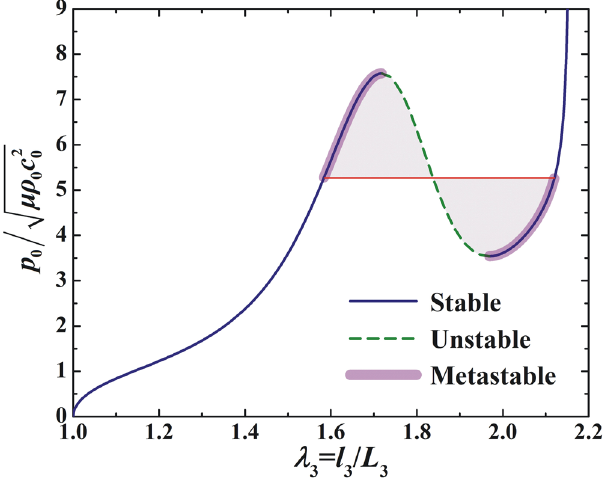
Figure 4. The acoustical load-stretch relationship exhibits snap-through instability with stable, unstable and metastable regimes (dashed line means unstable region). The metastable region is identified by applying the Maxwell